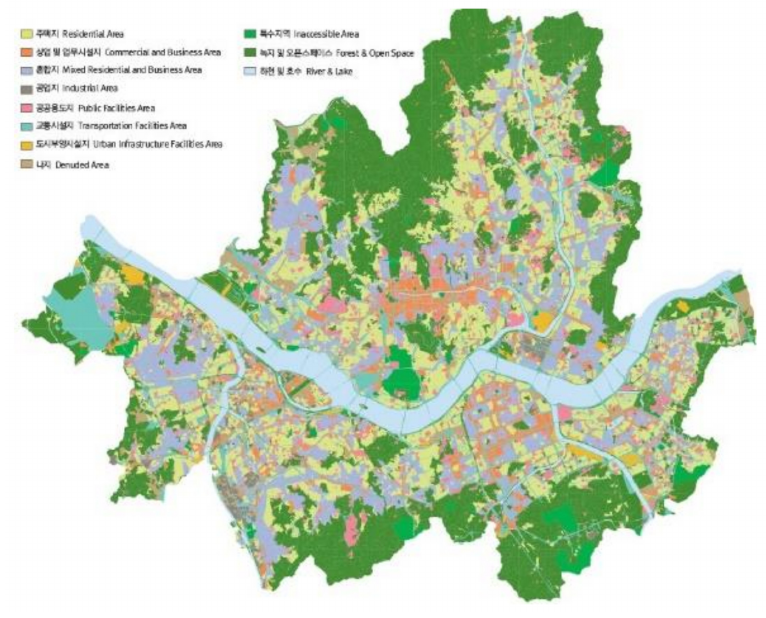
Figure 6. Status of land use (2010) [10].